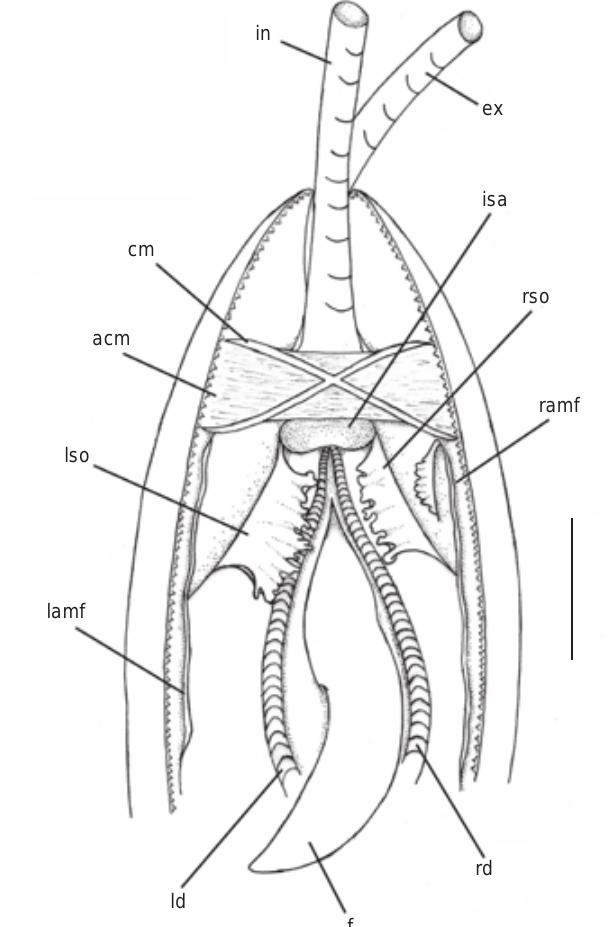
Figure 2. Macoma biota : ventral view representing 3/4 of a speci- men with the valves half-open showing the position of the siphonal organs and the accessory adductor and cruciform muscles. (acm) Accessory adductor muscle, (cm) cruciform muscle, (ex) exhalant siphon, (f) foot, (in) inhalant siphon, (isa) inhalant siphon proximal aperture, (lamf) left additional mantle fold, (ld) left inner demibranch, (lso) left siphonal organ, (ramf) right additional mantle fold, (rd) right inner demibranch, (rso) right siphonal organ. Scale bar: 5